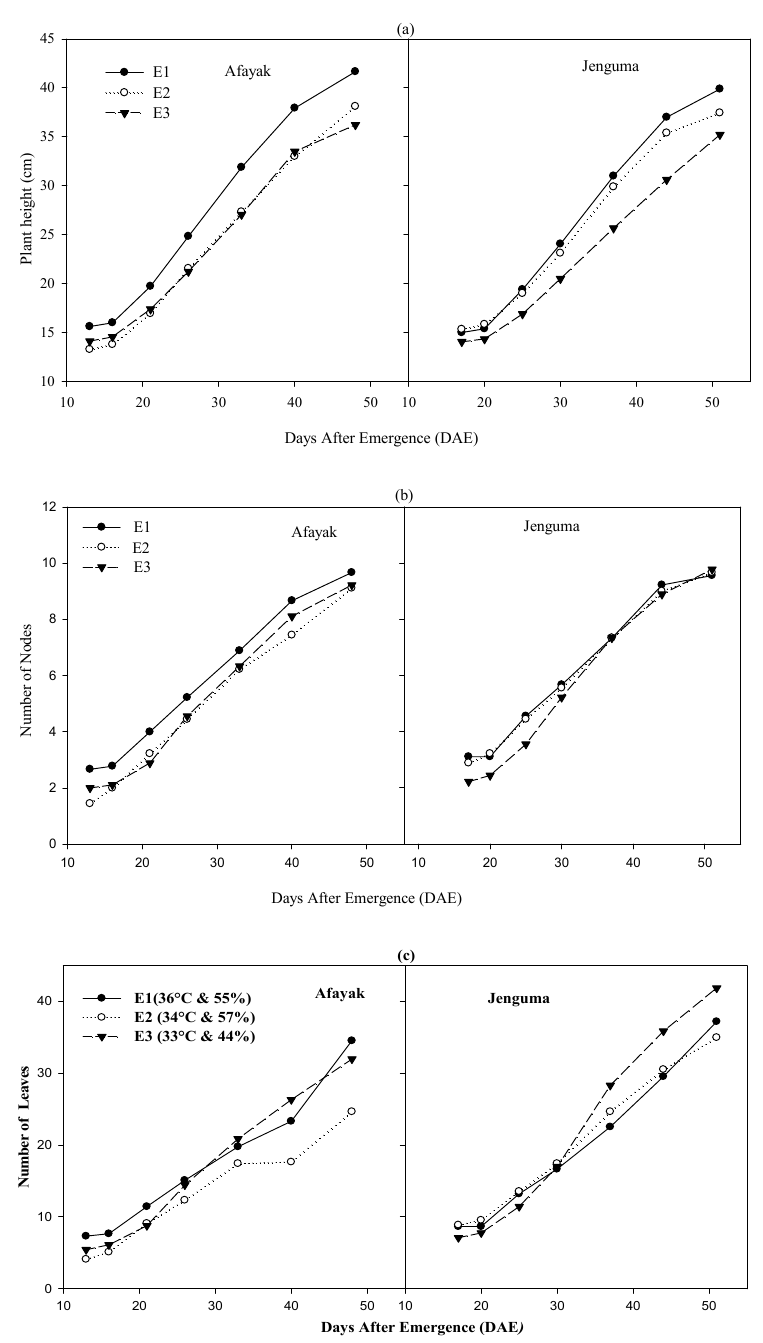
Figure 2. Differences in ( a ) plant height and ( b ) node appearance ( c ) leaf appearance for the two varieties under varying environment (E1: 36 °C, RH: 55%; E2: 34 °C, RH: 57%; and E3: 33 °C, RH: 44%).